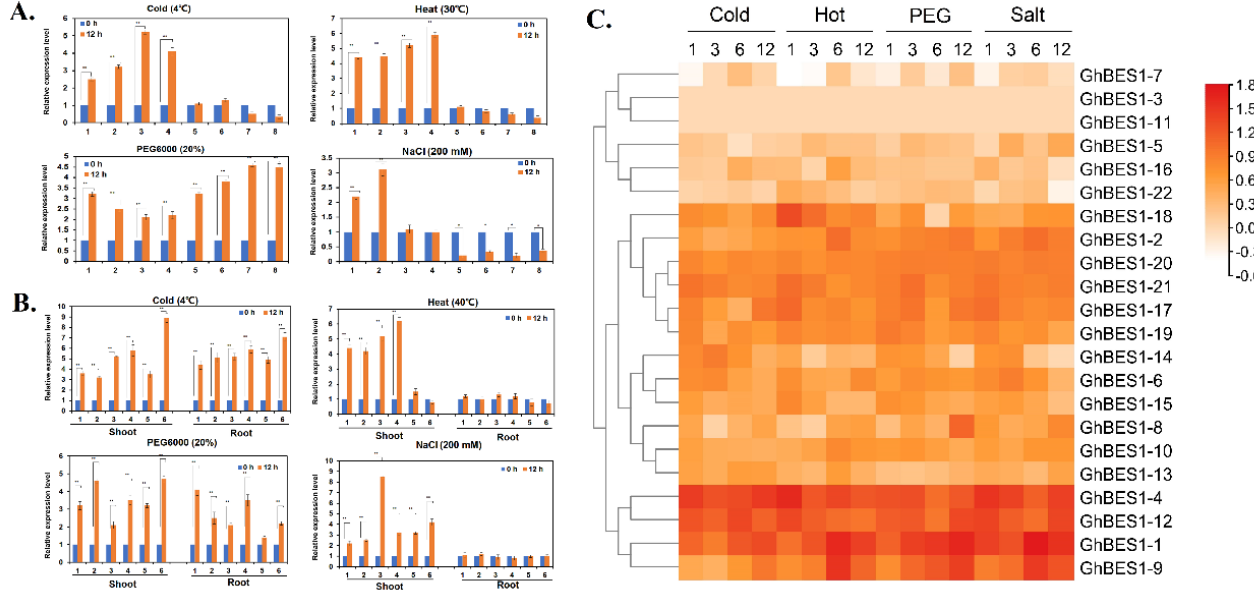
Figure 4. ( A ) Expression of BES1 family genes in Arabidopsis under different stresses. Numbers on the X-axis represent AtBES1s , and 1~8 represent AtBES1-1~AtBES1-8 . ( B ) Expression of BES1 family genes in rice under different stresses. Numbers on the X-axis represent OsBES1s , and 1~6 represent OsBES1-1~OsBES1-6 . ( C ) Expression of GhBES1 family genes under different stress treatments. (*: 0.01 < p < 0.05, **: p < 0.01; the resulting mean values were presented as relative units. Error bar represents SD).